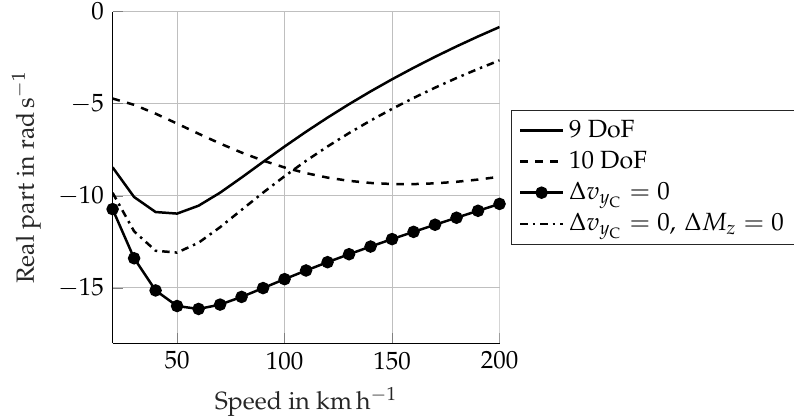
Figure 6. Effect of compensating ∆ v y compensated. In the dash-dotted curve both ∆ v y